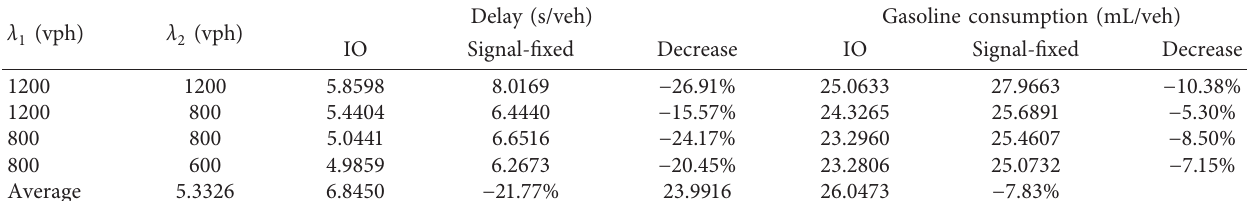
Table 2: The average vehicle’s delay and gasoline consumption in different